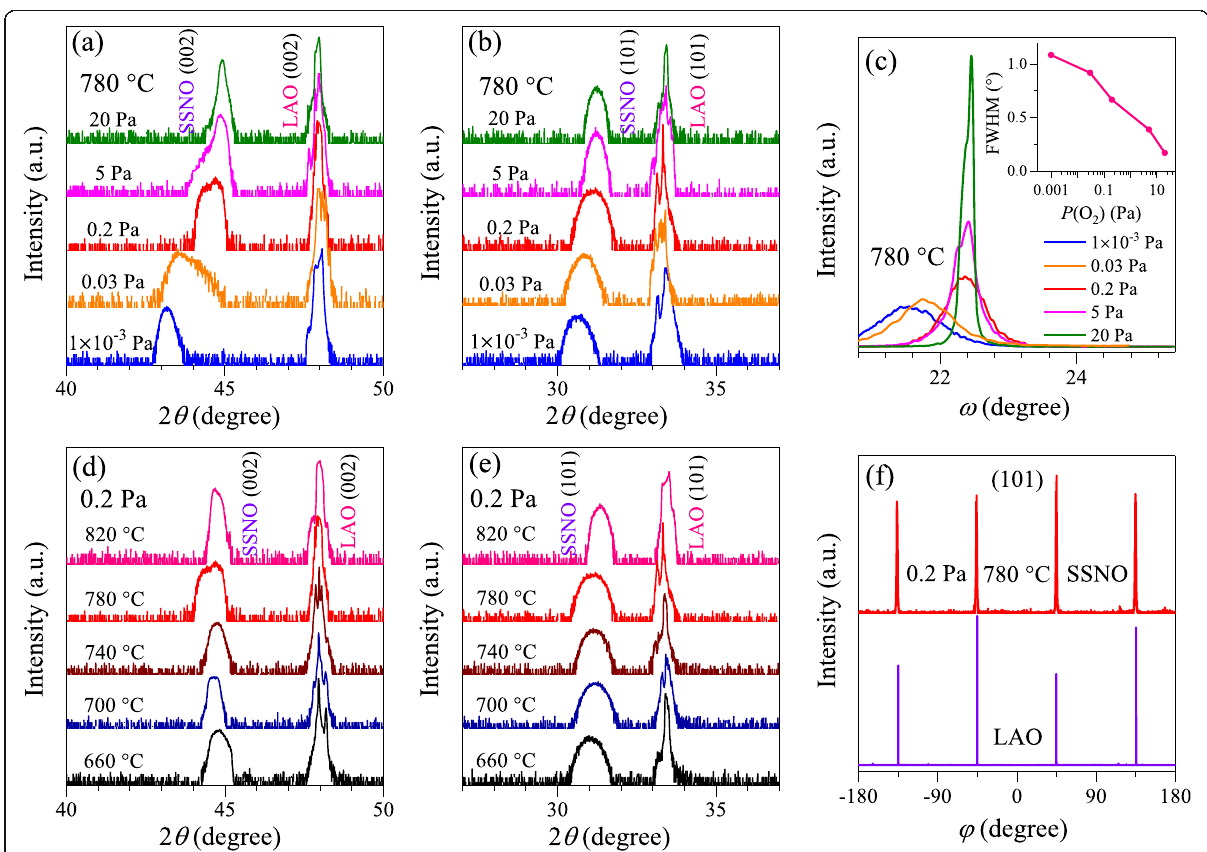
Fig. 1 XRD 2 θ - ω scan patterns of the SSNO films on LAO(001) substrates along a (002) and b (101) orientations with different oxygen pressures. c XRD ω -rocking curves taken on the (002) peaks of the films. The inset shows the FWHM results by varying oxygen pressure from 1 × 10 − 3 to 20 Pa. d and e are the 2 θ - ω scans of the films with various substrate temperatures along (002) and (101) planes, respectively. f φ scans of the SSNO film deposited at 0.2 Pa and 780 °C and LAO substrate around (101)